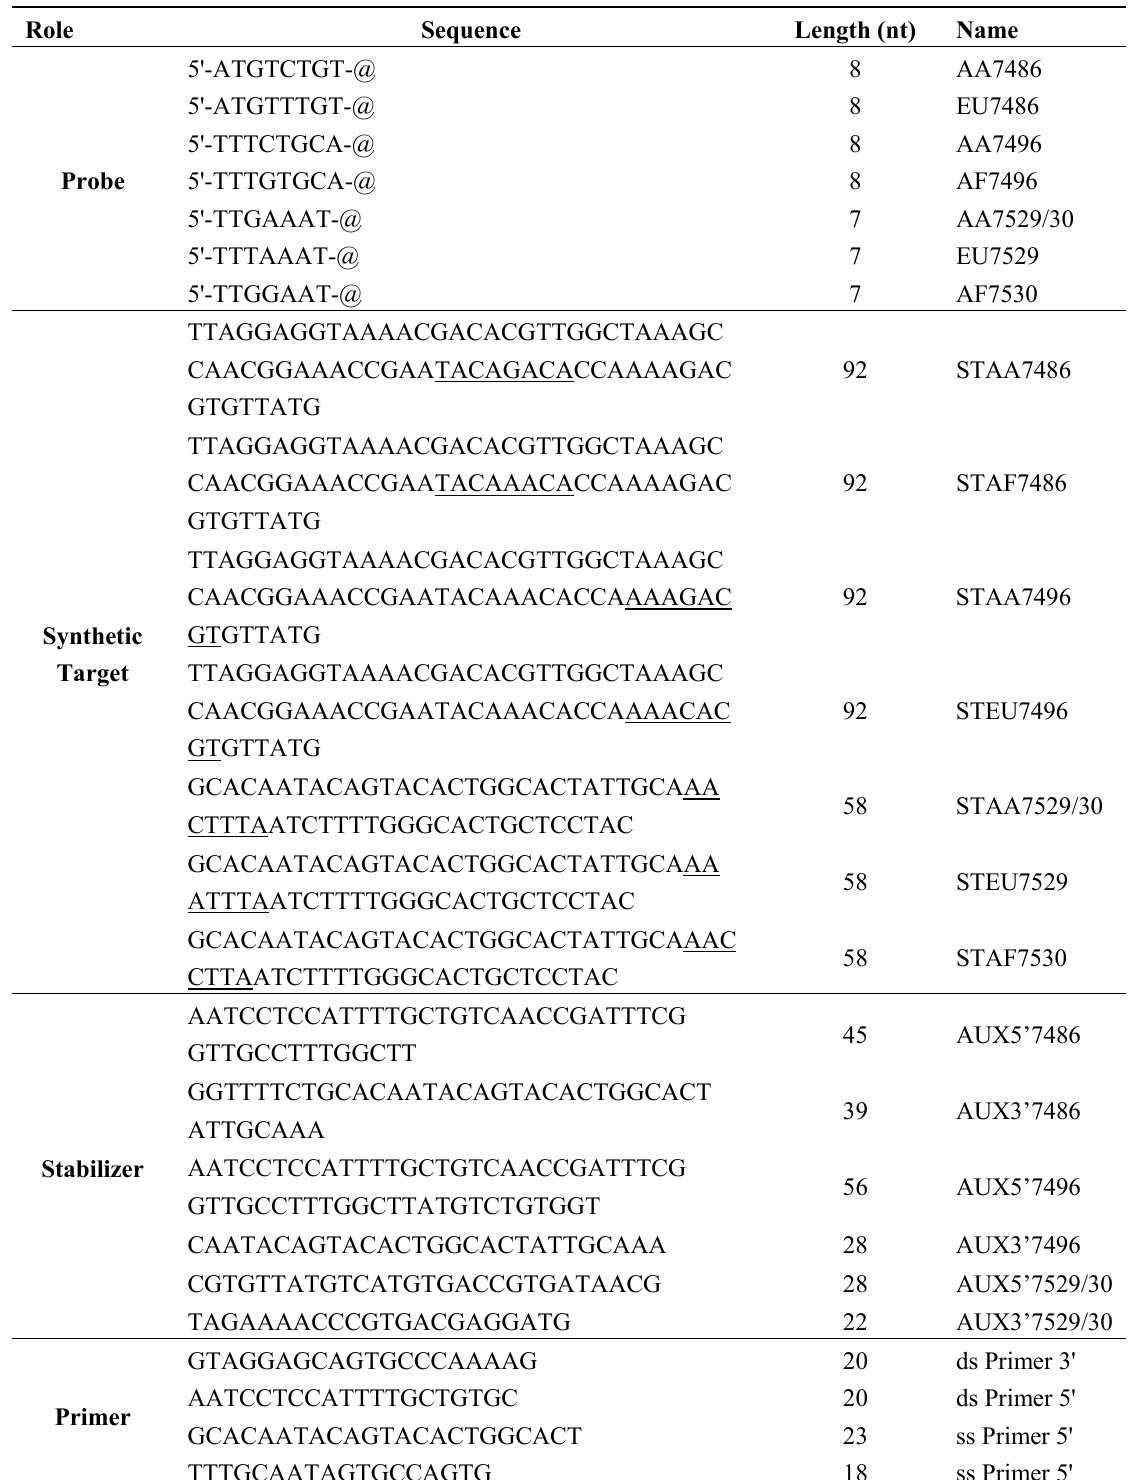
Table 1. Capture probes, stDNAs, stabilizers and primers employed for oligoarray development.